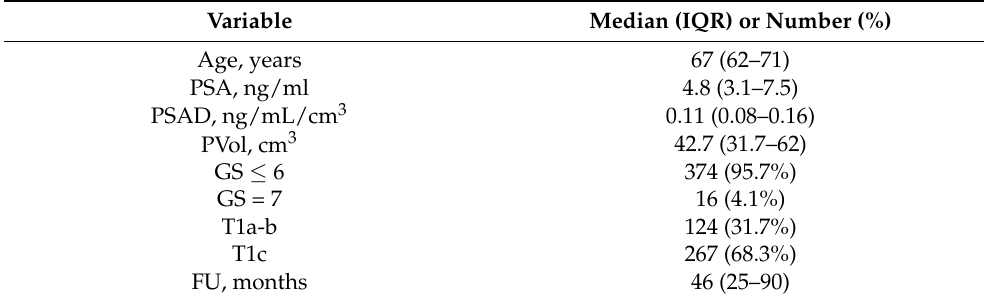
Table 1. Patient characteristics at inclusion.